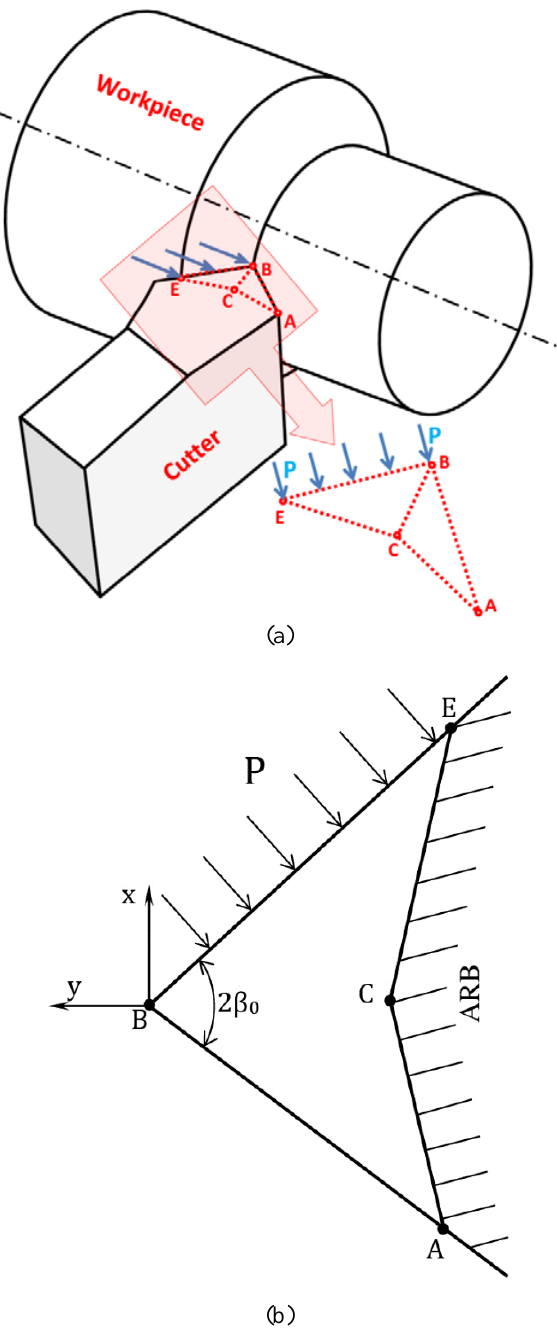
Fig. 2. Field of material slip curves in the region of plastic deformation of the cutting wedge of the tool, when ε = 2β 0 ≤